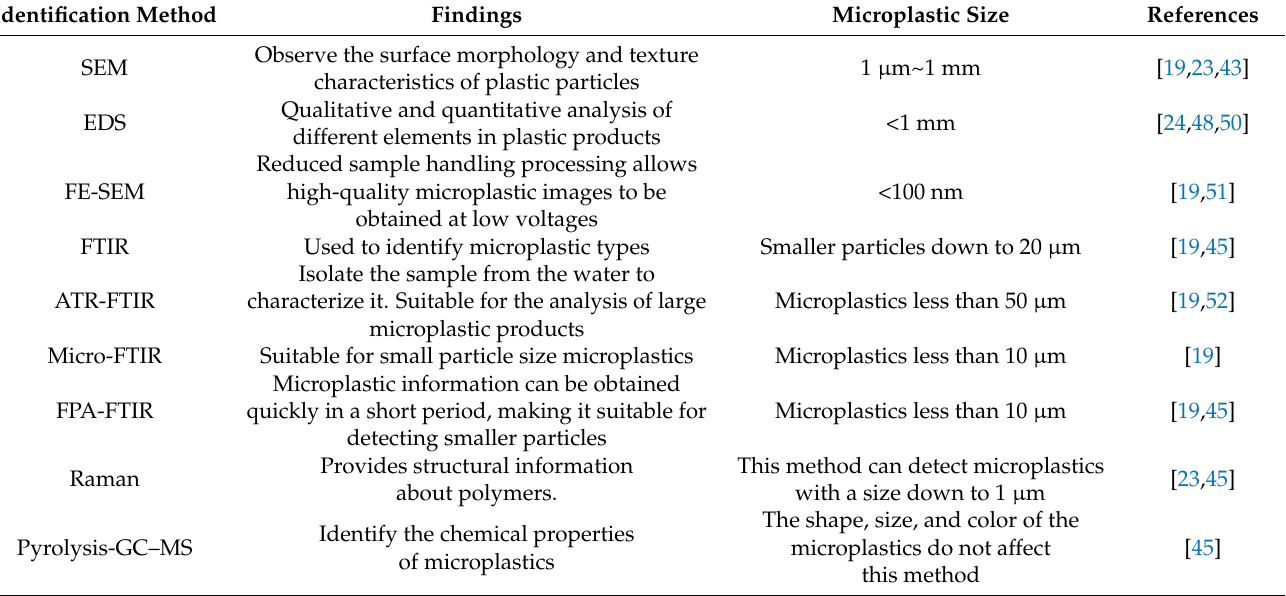
Table 1. Techniques for chemical characterization of